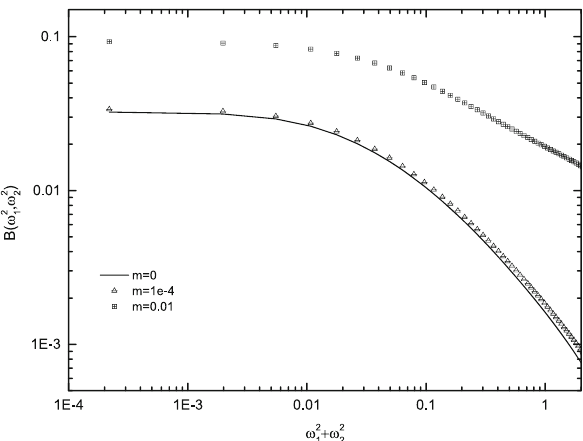
Fig. 3 The value of fermion self-energy with different mass of L = 300 , T = 0 . 01